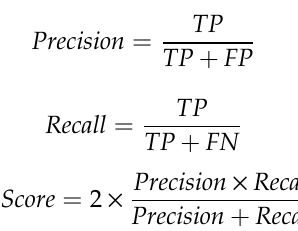
Table 4. Analysis of similarity for application of no normalization, existing normalization, time normalization, and fusion normalization for pre- and post-exercise